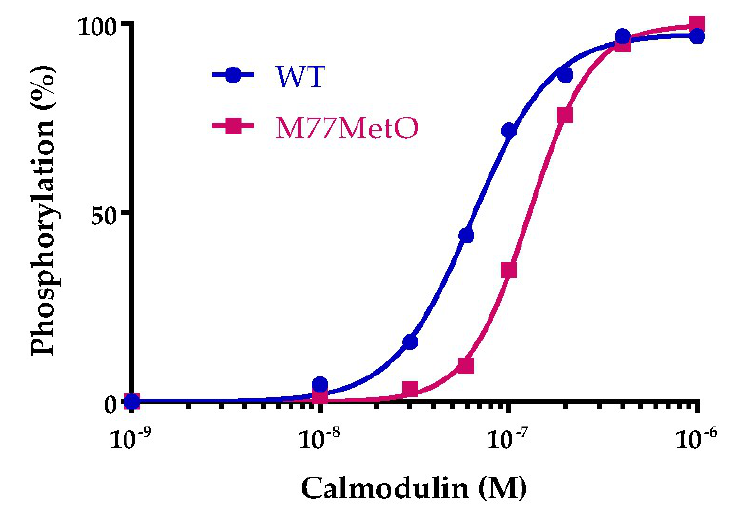
Figure 13. Activation of CaMKII α by wild type and M77MetO calmodulin. The experiment was performed in 3 separate experiments on different days and the values for each concentration of calmodulin were averaged to generate the plotted points. Curves were fit to an allosteric dose response by Prism.